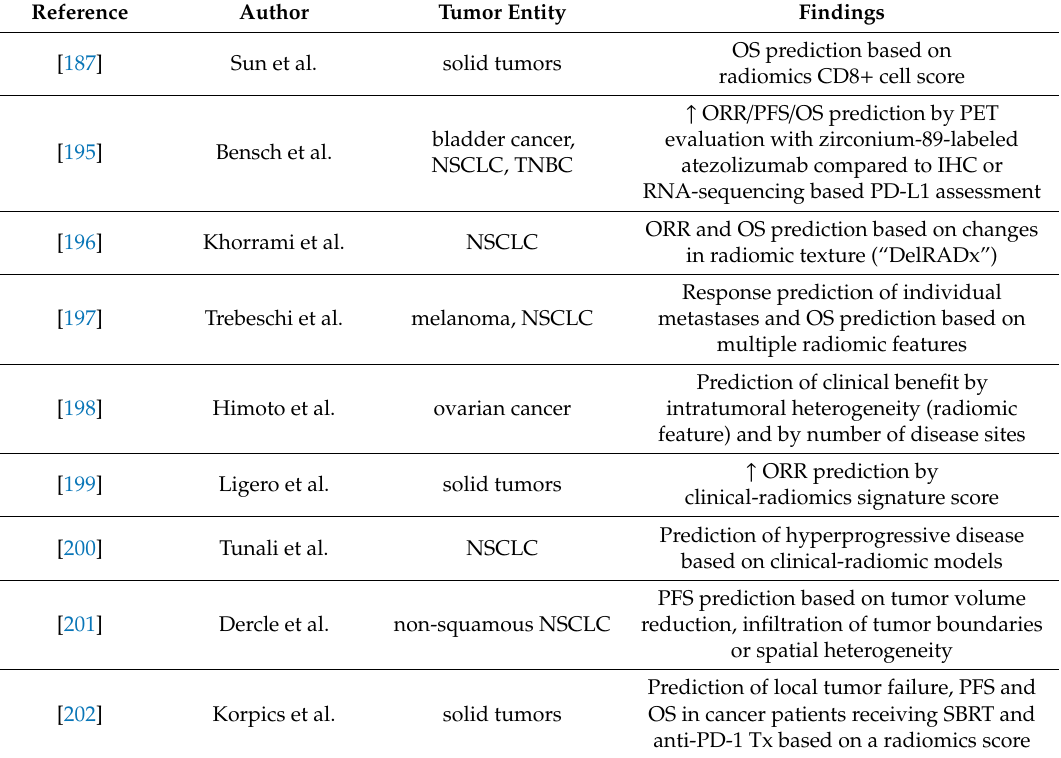
Prediction of clinical outcome by radiomics in cancer patients undergoing immune-checkpoint